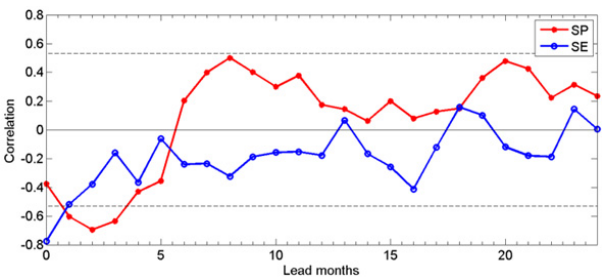
Fig. 9. Cross correlation coefficients between fire season BA and precipitation for the Southern Plains (SP) and Southeast (SE) re- gions for lead times of 0 to 24months prior to the start of the fire season. Dashed lines indicate the limits for statistically significant correlation at the 95% confidence